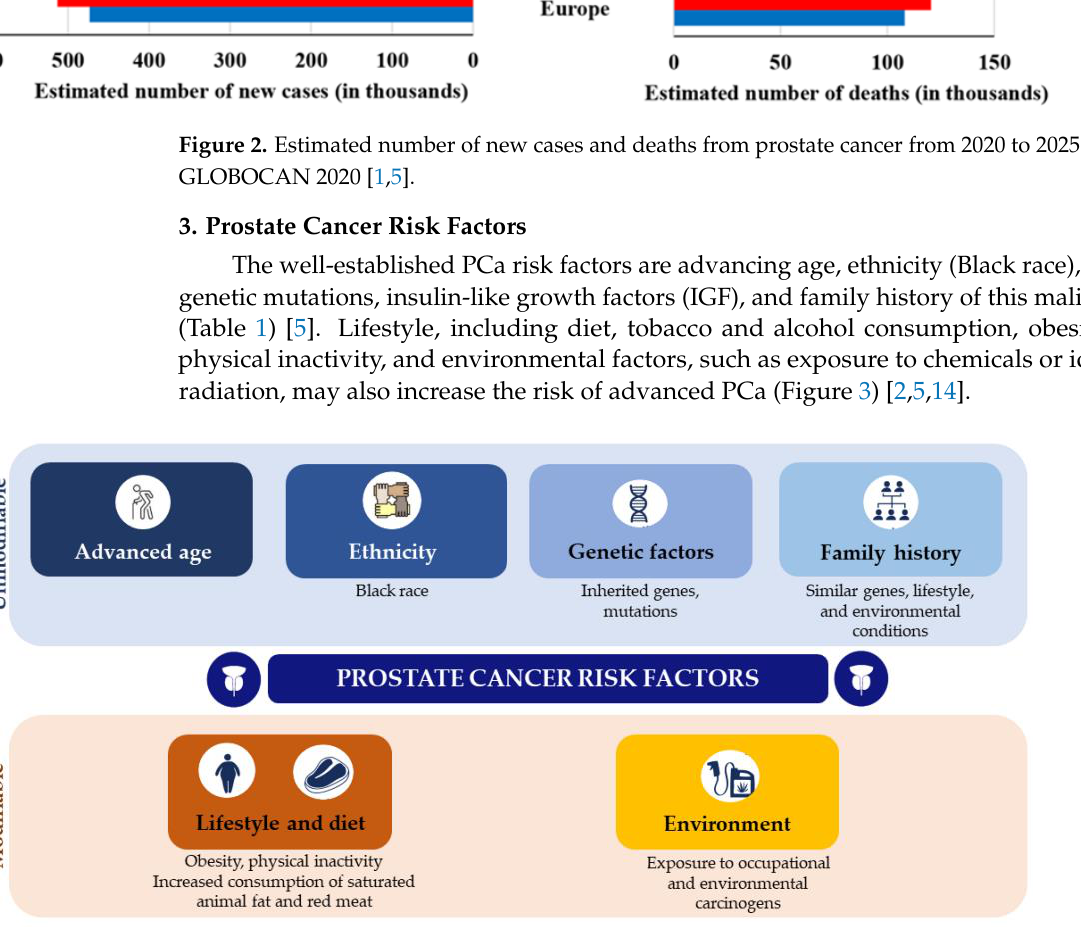
Figure 3. Modifiable and unmodifiable prostate cancer risk factors.